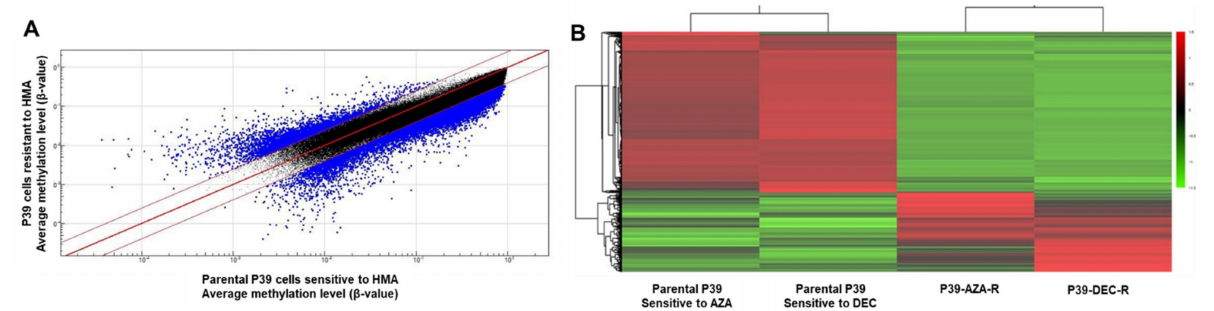
Figure 1. Differential methylation signature between hypomethylating agent (HMA)-resistant and sensitive P39 cells. ( A ) Scatter plot of differential methylation loci of hypomethylating agent-resistant and sensitive P39 cell lines. Average methylation levels of P39 cell line resistant to azacitidine and decitabine were compared with the mean methylation levels of P39 cells sensitive to azacitidine and decitabine. Differential methylation levels of at least 2.5-fold or 0.4-fold were included for downstream study as differentially methylated regions (DMRs); ( B ) Differential methylation signa- ture and functional prediction of differentially methylated regions (DMRs) in HMA-sensitive and HMA-resistant cells. Hierarchical clustering of DMRs showed a global hypomethylation signature during resistance to both azacitidine (AZA) and decitabine (DEC). Methylation in AZA-resistant P39 cell line (P39-AZA-R) and DEC-resistant P39 cell line (P39-DEC-R) differed by a small number of hypermethylated genes. The sensitive parental P39 cells were treated separately with AZA and DEC at 1 µ M for 48 h followed by immediate harvest for the assessment of methylation